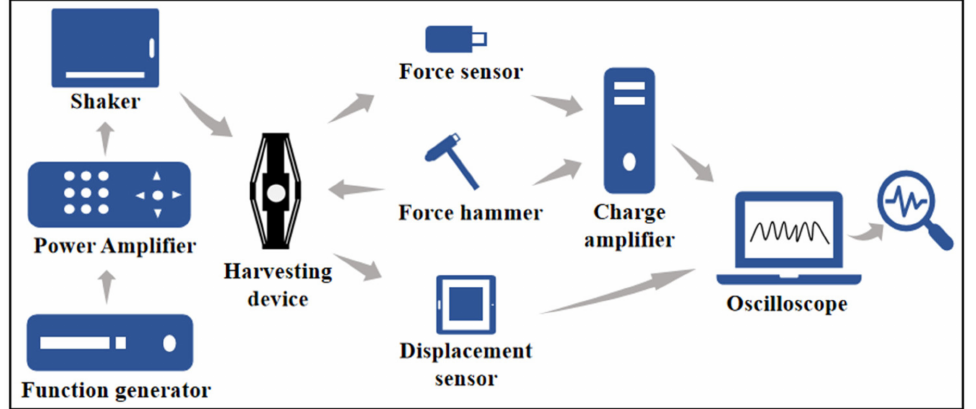
Figure 12. Experimental test